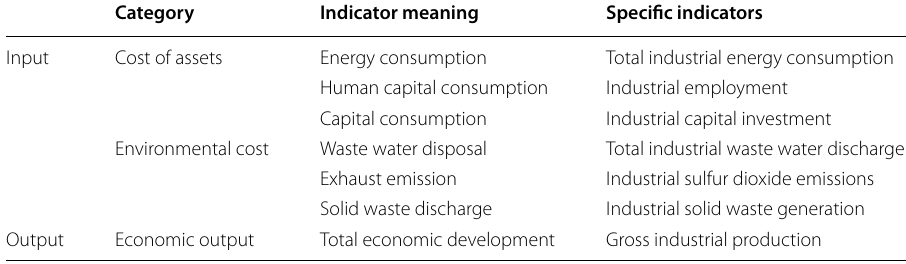
Table 1 Industrial environment efficiency measurement index